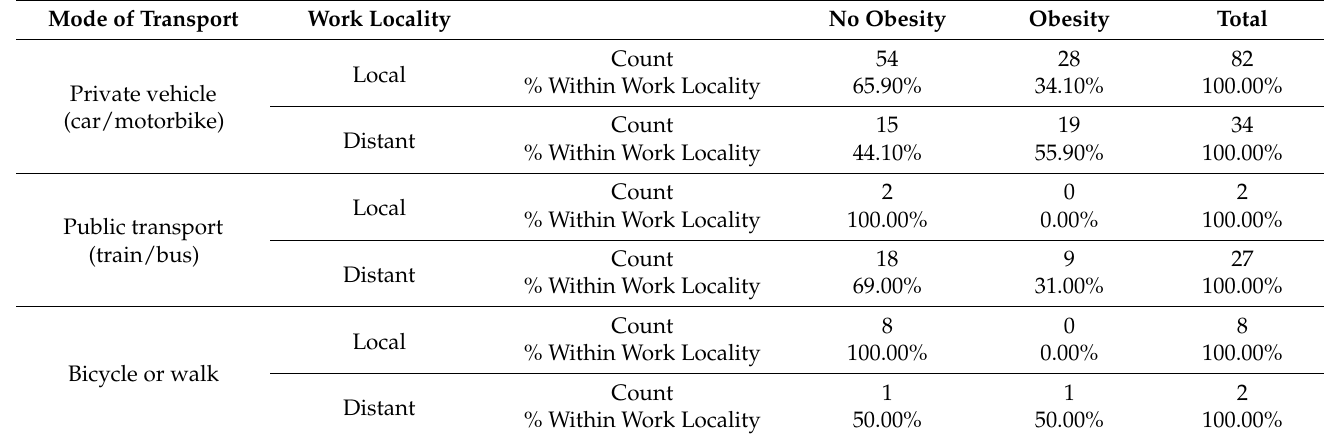
Table 3. Stratification of mode of transport according to work